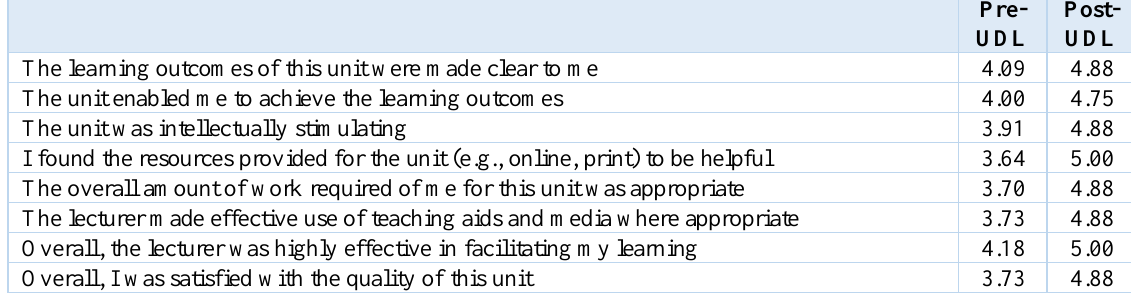
Comparison of Student Evaluation Scores between Pre- and Post-Universal Design for Learning (UDL) Student Cohorts (1.00=highly unstatisfied-5.00=highly satisfied)